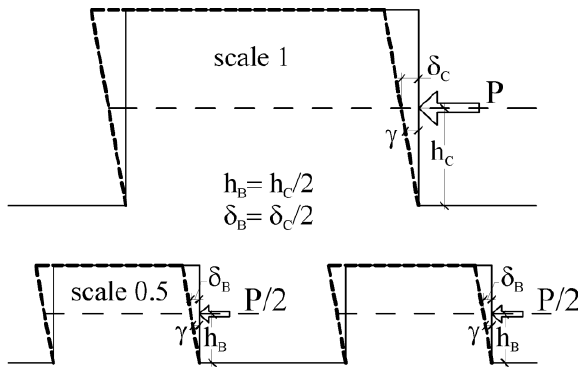
Figure 28: Effect of the size of steel dowels: illustration of ductility δ defined by the angle and height of the dowel [5] (later